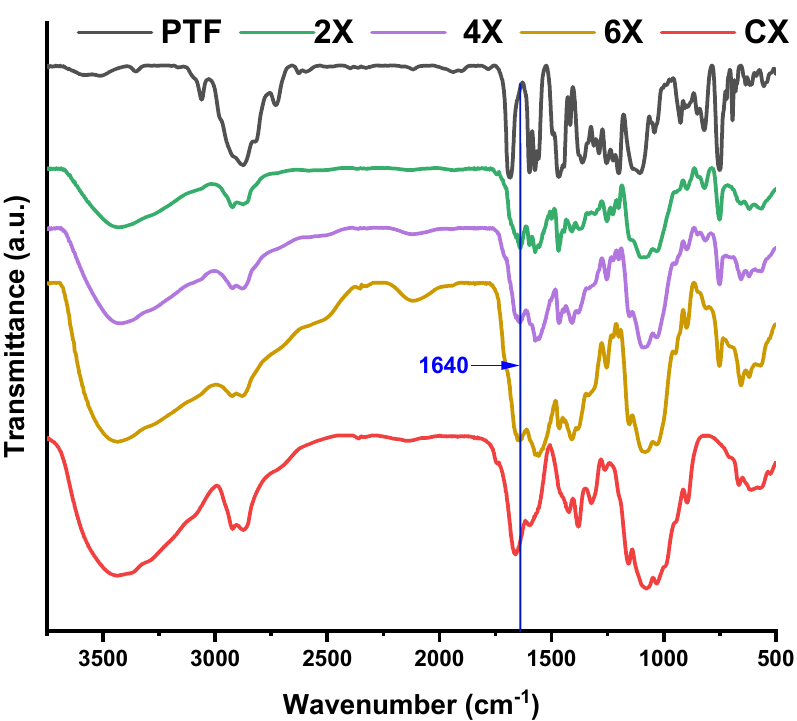
Figure 2. Comparative FTIR spectra of the xerogels, PTF, and chitosan.